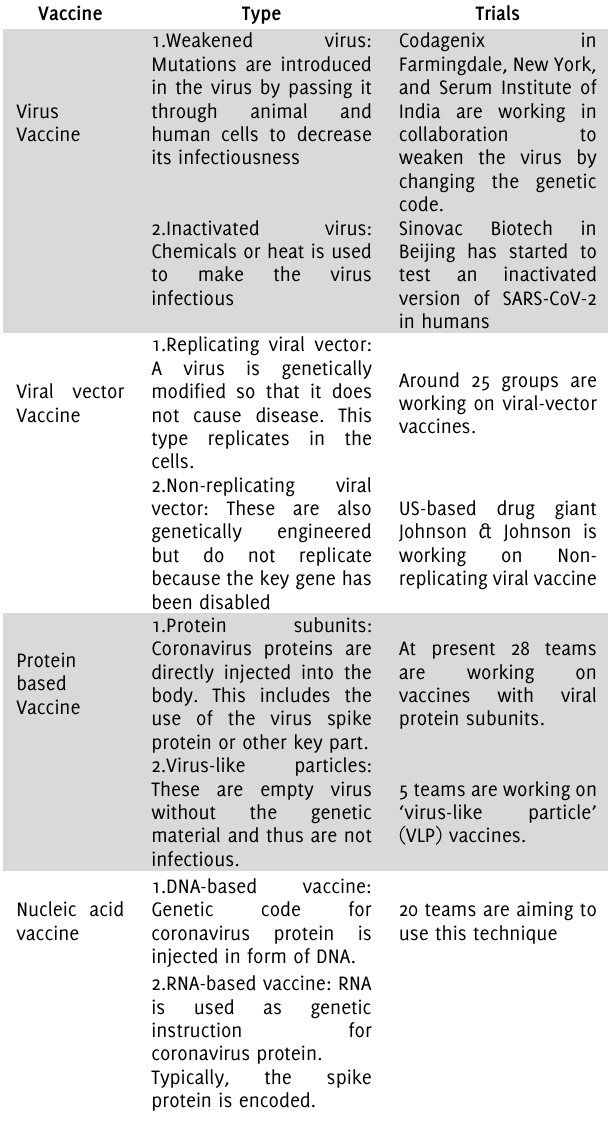
Table 3. Current state of COVID-19